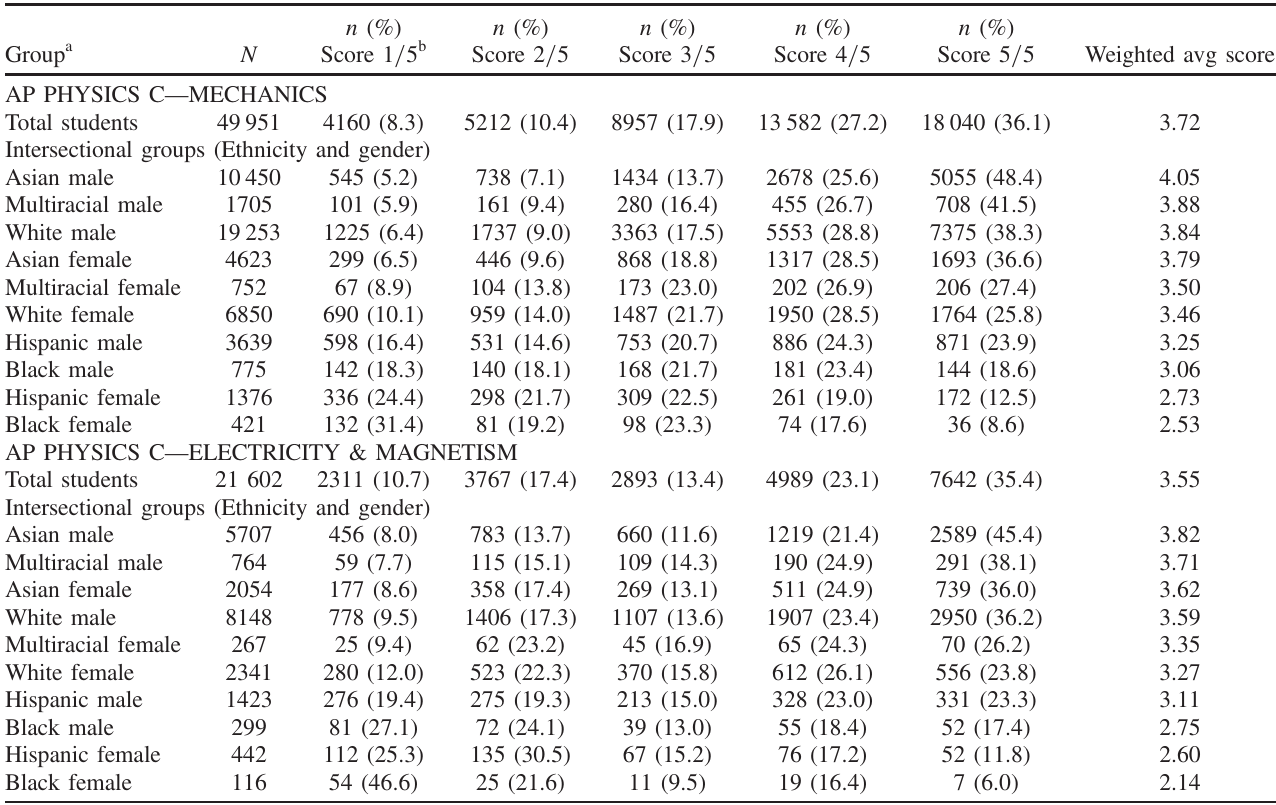
TABLE III. Score distributions in AP Physics C Mechanics and Electricity & Magnetism, disaggregated by intersectional group and the number and percentage of students in each group earning scores 1 through 5